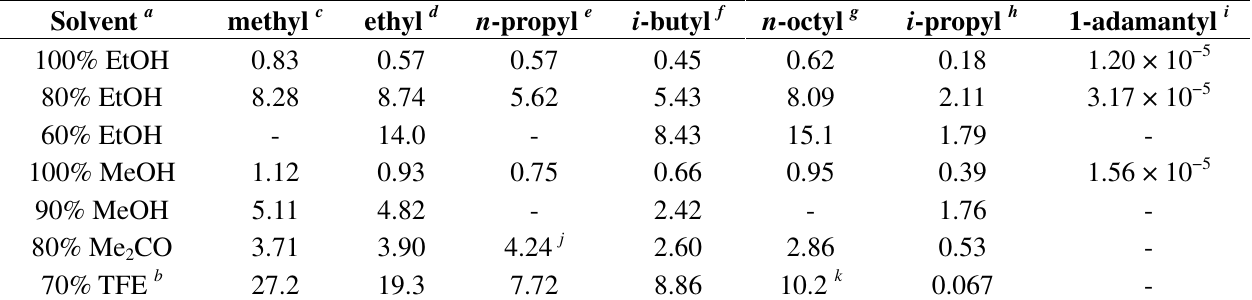
Table 5. The specific rate ratios ( k binary solvents at various